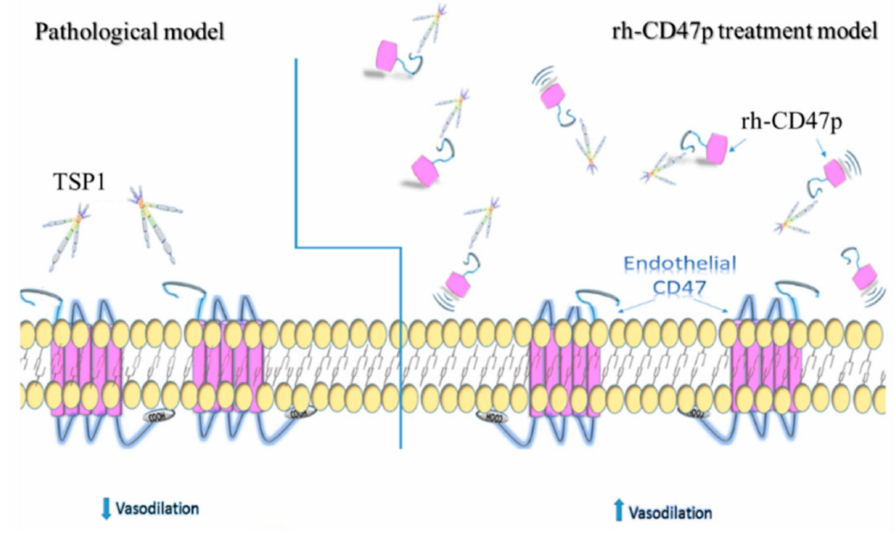
Figure 7. Schematics illustrating the putative alleviation mechanism of TSP1-impaired vasodilation via administration of recombinant human CD47 peptide (rh-CD47p). Under pathological conditions, excessive TSP1 is present in circulation or acutely excreted upon damage to the vascular wall. Under either pathological condition, excessive TSP1 significantly alters vascular tone via binding to its cognate receptor CD47 expressed on vascular cells, presenting as inhibited endothelium-dependent vasodilation. rh-CD47p, containing the TSP1 binding domain, was given prior to or after exposure to TSP1 to interfere with the communication between TSP1 and endothelial CD47, showed in the panel of the rh-CD47p treatment model. Since the signaling cascade initiated upon the interaction between TSP1 and endothelial CD47, TSP1-impaired endothelium-dependent vasodilation was expected to be prevented or restored as rh-CD47p was administered prior to or after the TSP1 challenge,